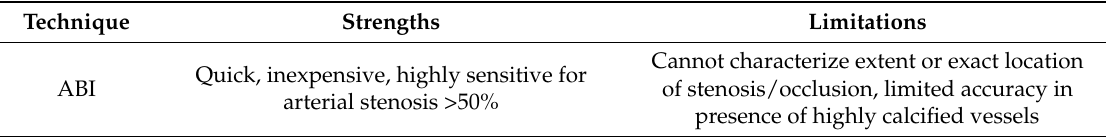
Table 1. Screening and Diagnostic Tools in Peripheral Arterial